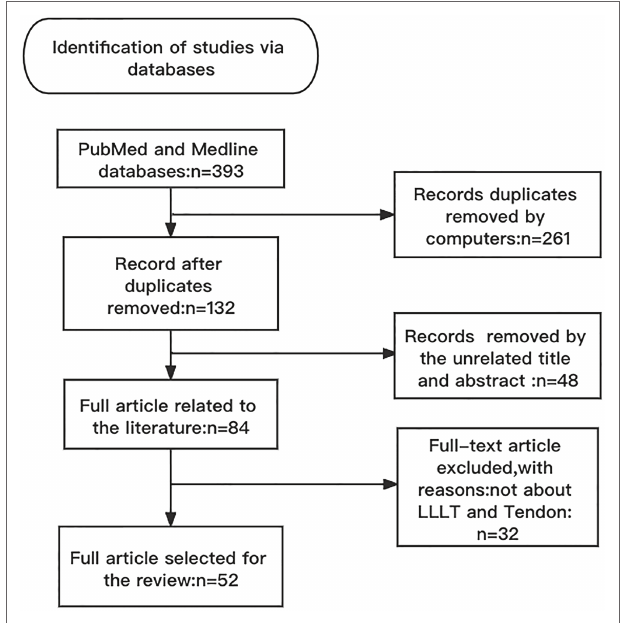
FIGURE 1 | Article retrieval flow chart with inclusion and exclusion